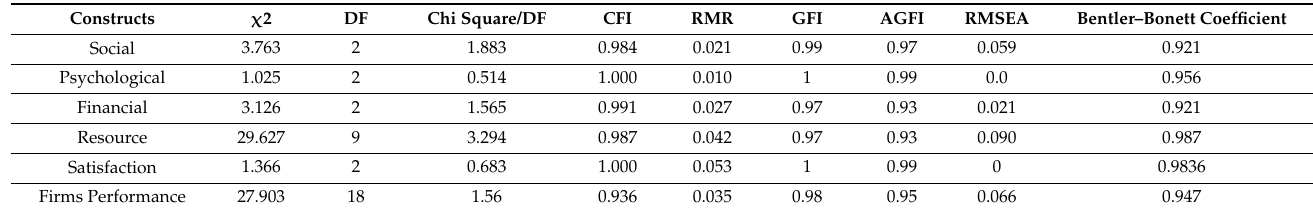
Table 4. Summary of goodness-of-fit.